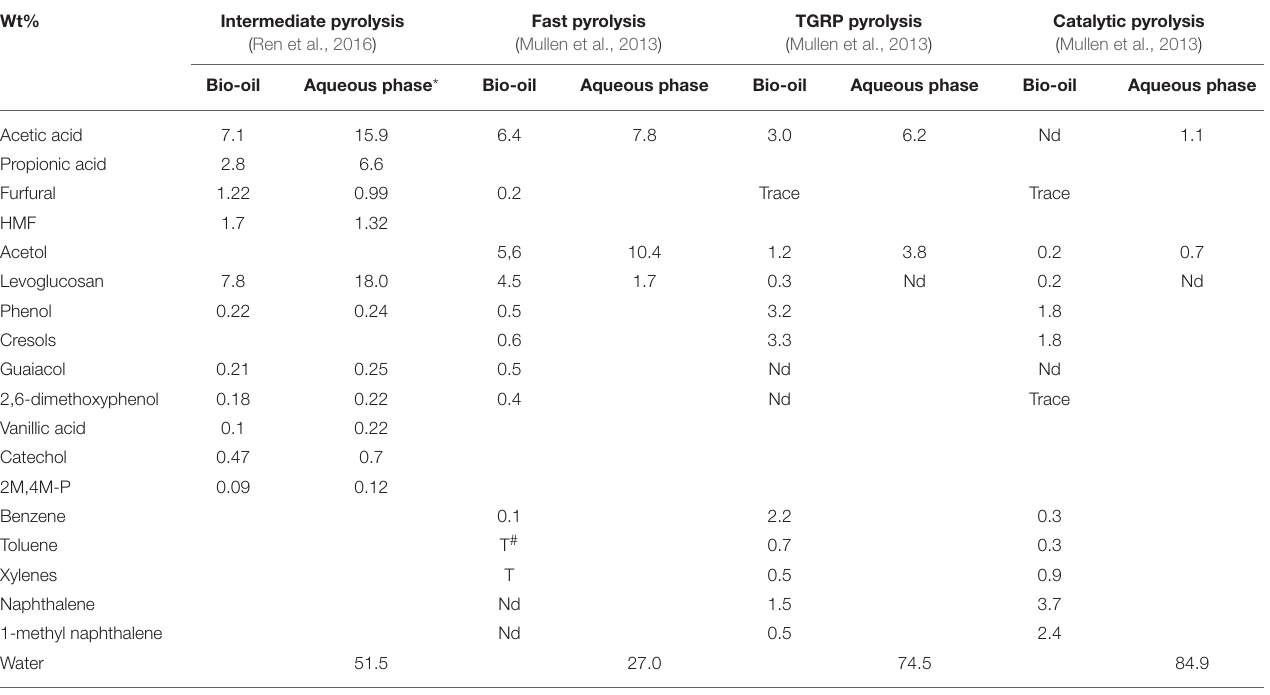
TABLE 2 | Comparison of chemical composition of pyrolysis bio-oil and the corresponding aqueous phase (wt%) generated during pyrolysis or via subsequent separation.